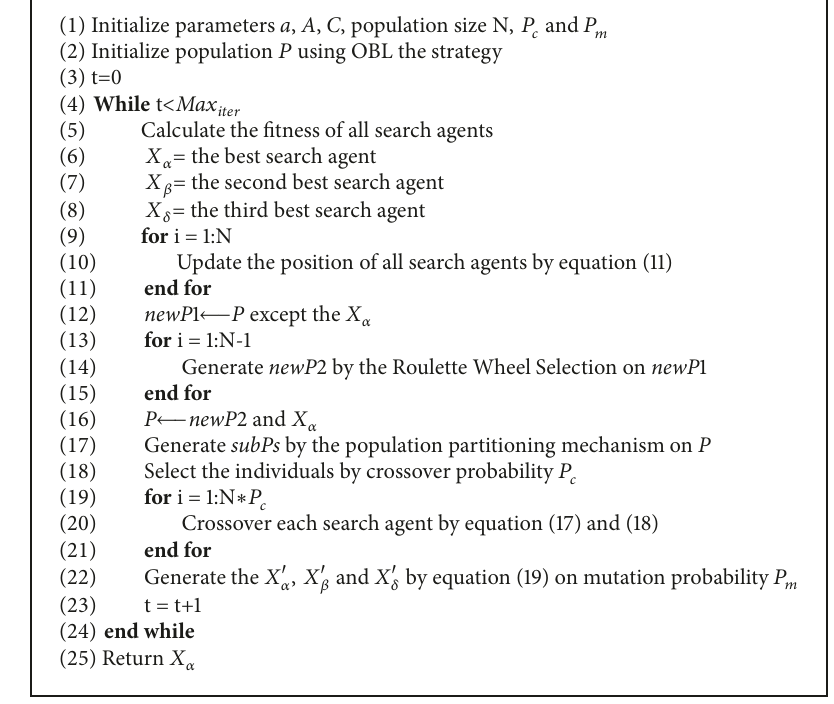
Algorithm 1: Pseudo code of the